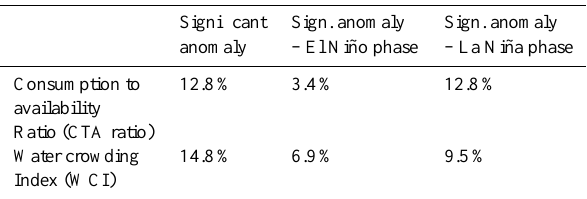
Table 4. Percentage of the global land area for which FPUs show significant anomalies in the median values of water scarcity condi- tions between the El Niño (EN) and La Niña (LN) phase, compared to the median values under all years. Water scarcity conditions were assessed by means of the CTA ratio for water stress and WCI ratio for water